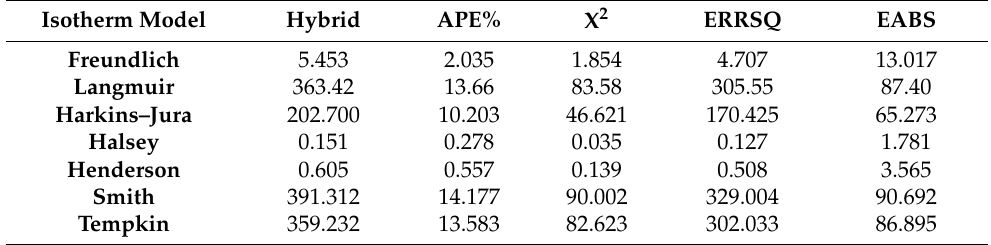
Table 4. The values of the five various error assessments of isotherm models for adsorption. Isotherm Model